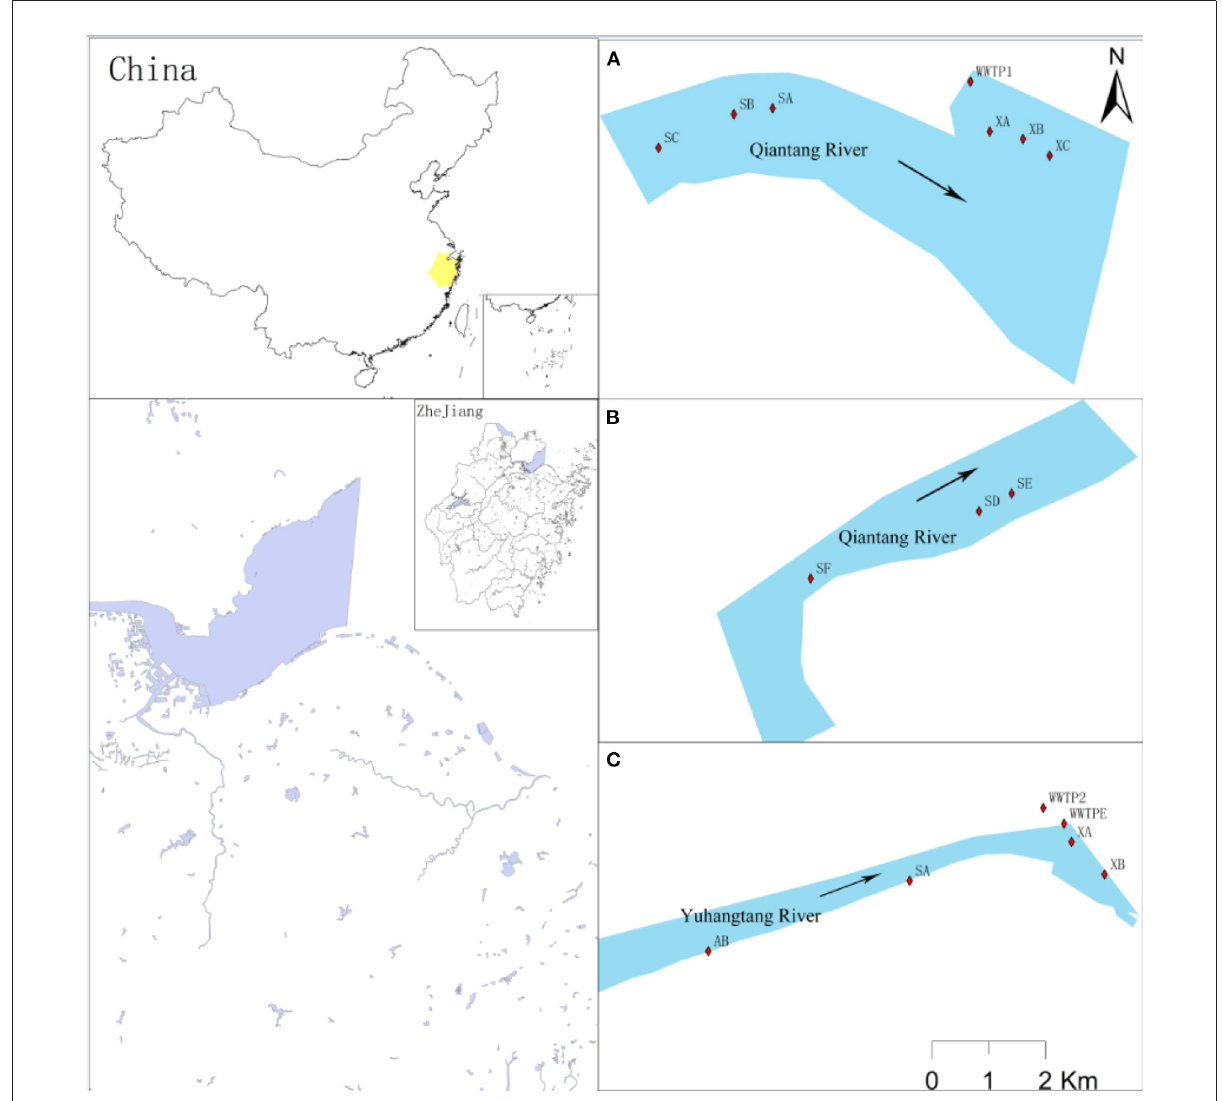
FIGURE1 (A) Sampling locations in Qiantang River and WWTP 1. S(A,B,C) upstream of WWTP1, X(A,B,C) downstream of WWTP1. (B) Sampling locations in Qiantang River. S(D,E,F) locations of source water from the three DWTPs. (C) Sampling locations in Yuhangtang River and WWTP 2.